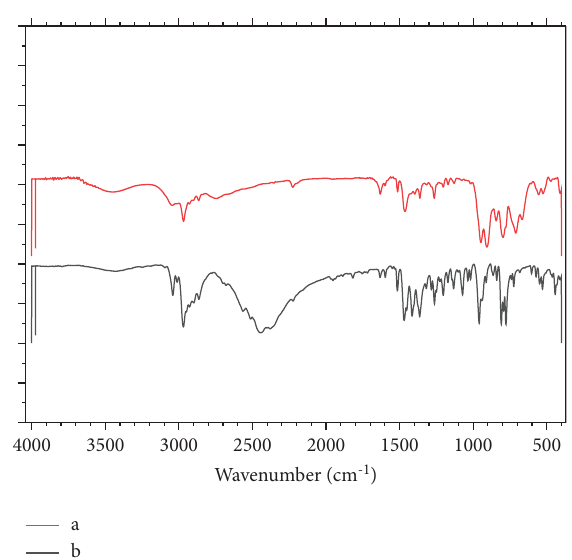
Figure 3: FTIR spectra terbinafne: ammonium heptamolybdate ion pair (a) and terbinafne drug